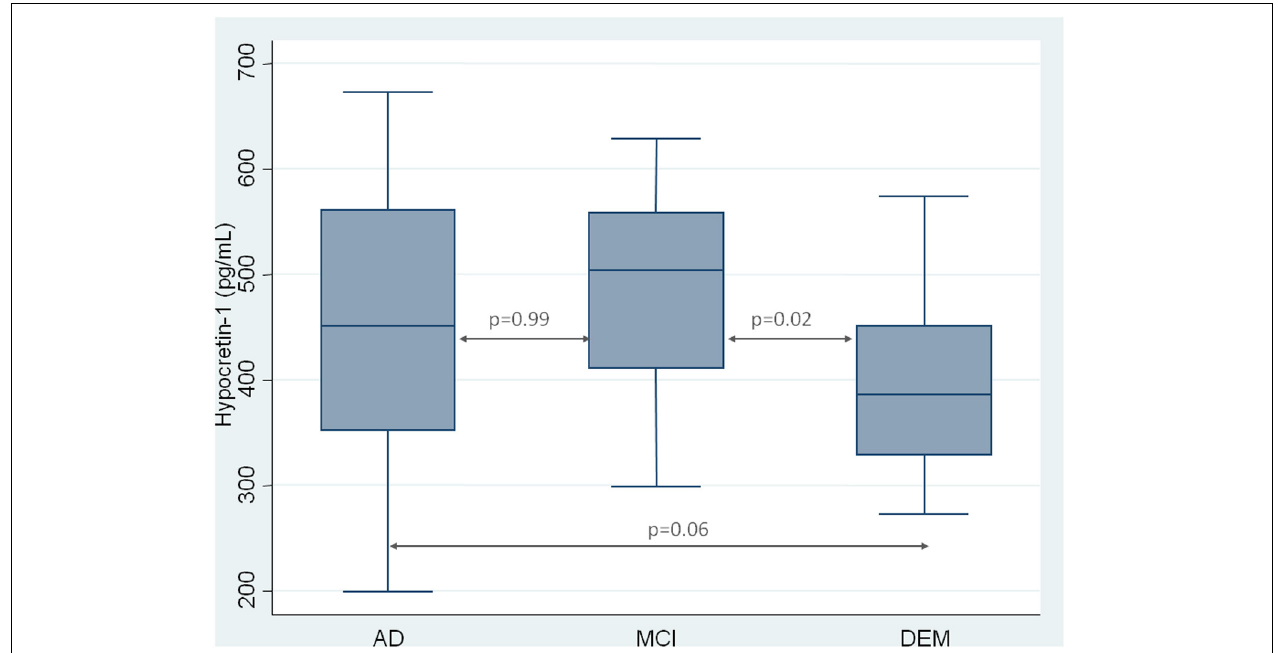
FIGURE 1 | CSF measurement of hypocretin-1 in patients with Alzheimer Disease (AD), Mild Cognitive Impairment (MCI), and with others Dementia (DEM). Results are shown as a box-whisker plot, with median and 25th quartile of CSF hypocretin-1 levels.